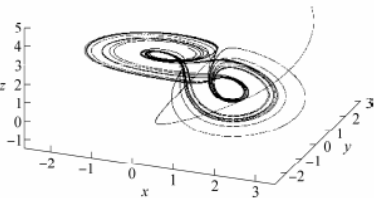
Figure 1. Phase diagram of the financial system (1) for t ∈ [ 0,10,000 ]